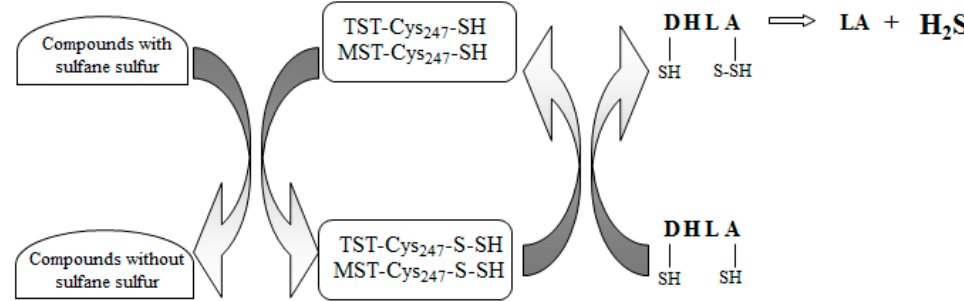
Figure 6. Role of LA/DHLA system in the interconversion of H 2 S and sulfane sulfur in the rat liver and kidneys. DHLA accepts sulfur atoms from sulfane sulfur-containing persulfide group of Cys-247, located in the active center of 3-mercaptopyruvate sulfurtransferase (MST) and/or thiosulfate:cyanide sulfurtransferase, rhodanese (TST). In this process, DHLA hydropersulfide is formed from which sulfur is released in the form of H 2 S, and LA is produced concomitantly (according to [44], modified).